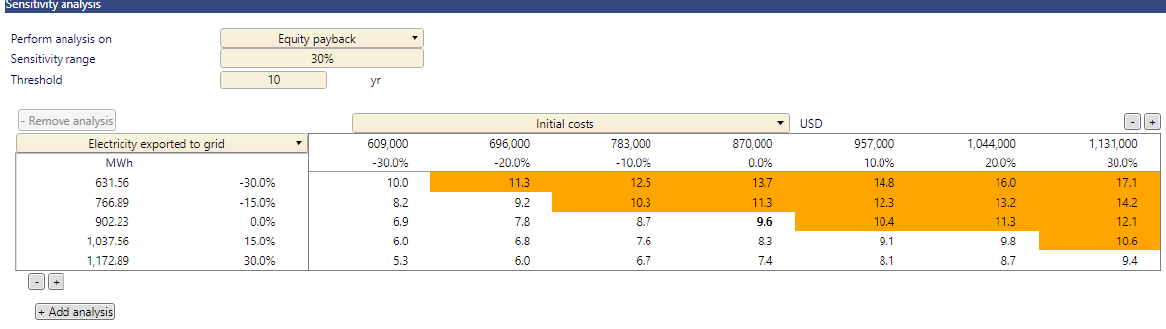
Figure 11. Sensitivity of 650 kW solar–wind RES plant to initial cost and electricity exported to the grid for 0.1 USD/kWh.